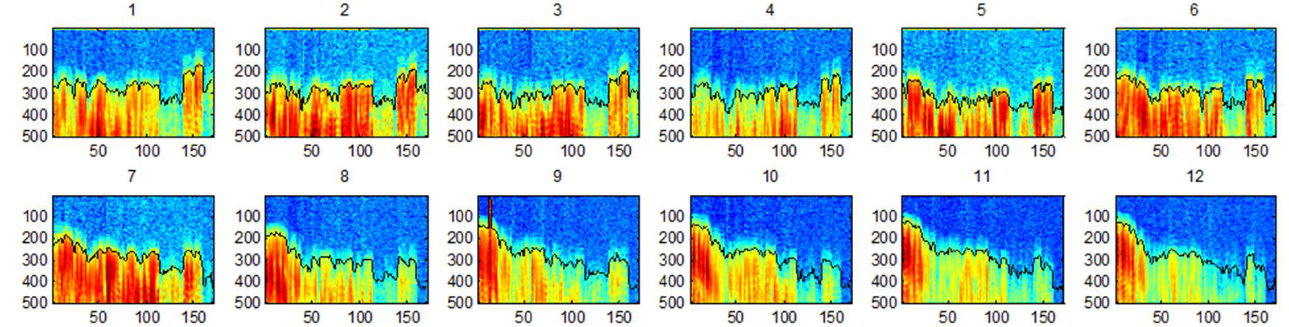
Figure 16. B-scan images from 12 positions of emitters of axis X. The black line represents the automatically detected beginning of the wave.